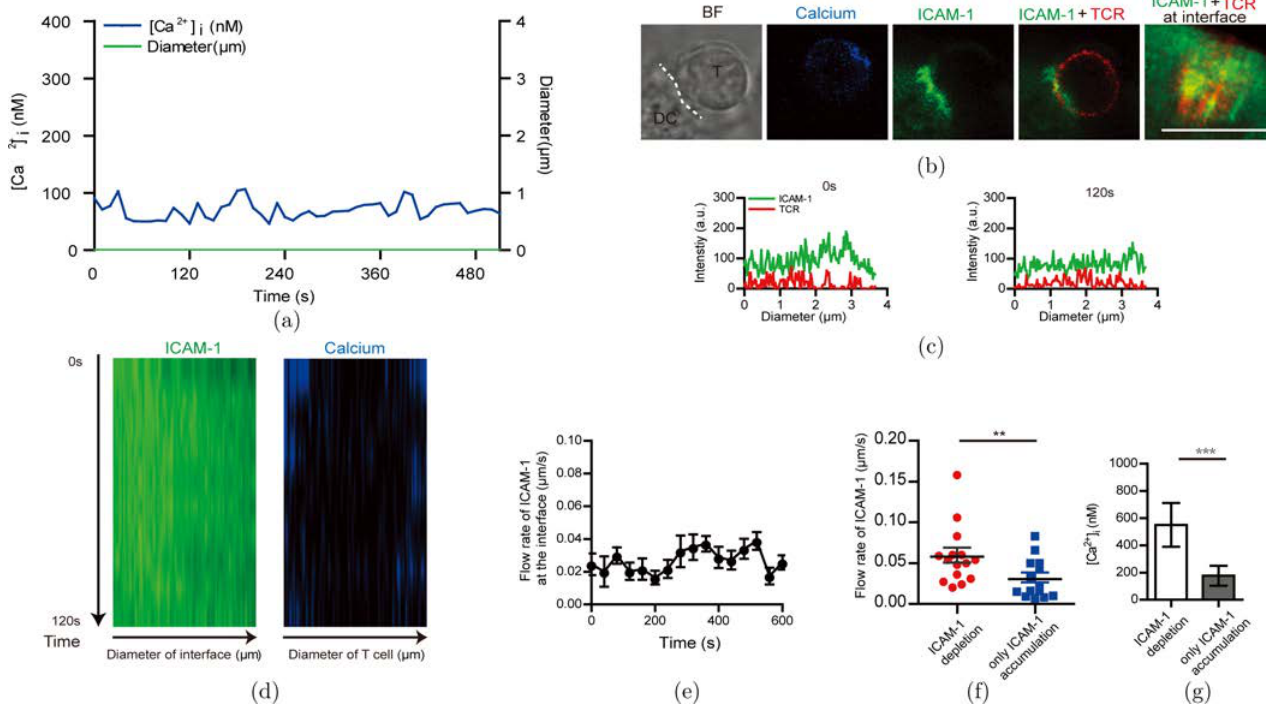
Fig. 2. The movement of ICAM-1 in the immature IS, which only accumulated ICAM-1 in the IS, and calcium release in a T-cell forming an immature synapse: (a) The relationship between the diameter change of the area of ICAM-1 depletion and calcium signaling in a T-cell. The movement of ICAM-1 at the interface of the synapse and calcium signaling in the T-cell contacted by the DC was detected by confocal microscopy with frames per 40 s. (b) The imaging of calcium signaling in a T-cell and its contact with a DC. Bar ¼ 2 (cid:2) m. (c) Analysis of the distribution of the °uorescent values of ICAM-1 and TCR along the diameter of the synapse at 0s and 120 s. (d) Kymograph analysis of the relationship between ICAM-1 movement and calcium release in a T-cell. (e) The °ow rate of ICAM-1 in the synapse during formation of T-DC contact. (f) The °ow rate of ICAM-1 in the T-DC contact that had ICAM- 1 depletion in the center of the synapse or in the T-DC contact that only had ICAM-1 accumulation. (mean (cid:4) s.e.m., n ¼ 15, three independent experiments), ** p < 0 : 01 (two-tailed Student's t -test). (g) The concentration of calcium in T-cells which formed an IS with ICAM-1 depletion or that in T-cells which formed an IS with only ICAM-1 accumulation (mean (cid:4) s.e.m., n ¼ 25, three independent experiments), *** p < 0 : 001 (two-tailed Student's t